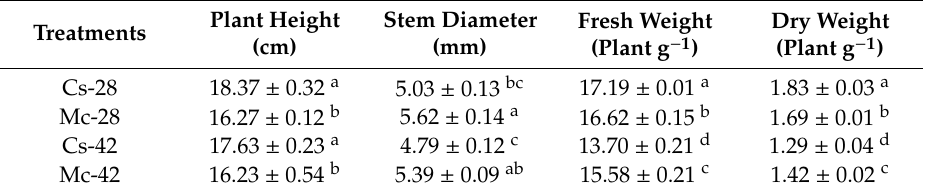
Table 1. Interactive e ff ects of bitter melon rootstock on the growth of grafted cucumber seedlings after 7 days of high temperature stress.